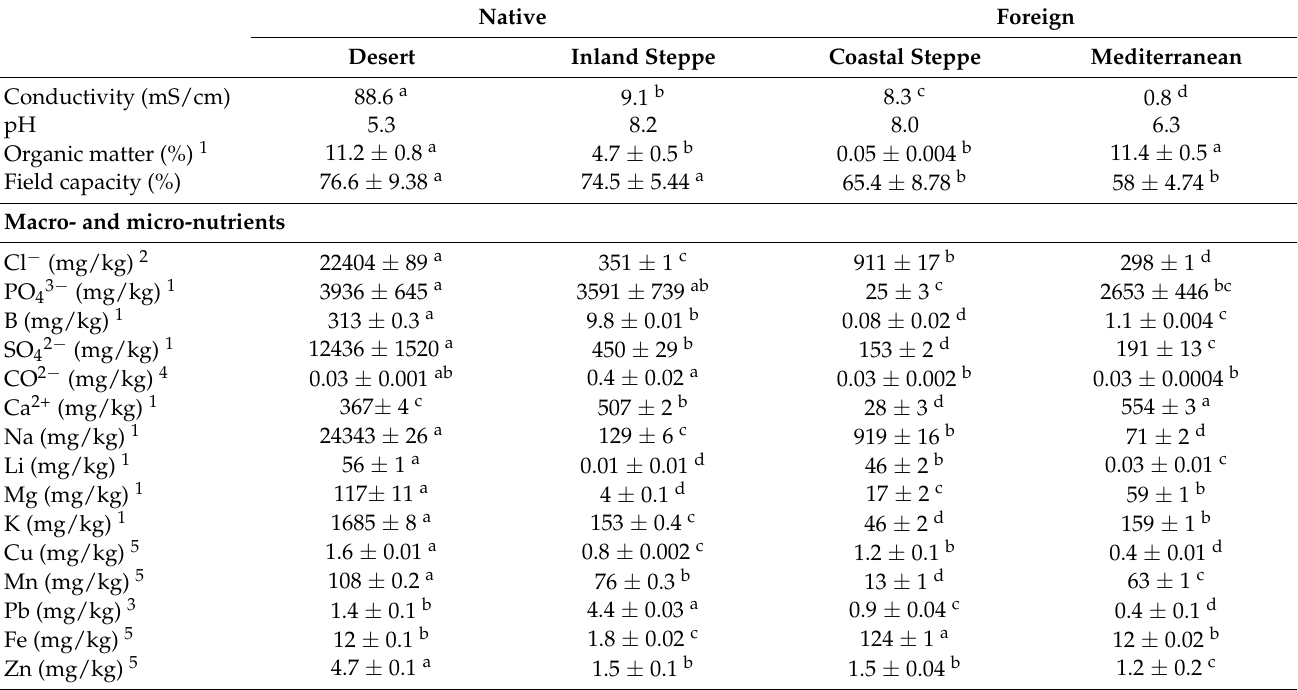
Table 1. Soils characterization. Numbers represent mean value ± Standard deviation of n = 3 soil samples. Superscript lowercase letters represent Fisher’s least significant difference (LSD) when α = 0.05 from Kruskal–Wallis testing differences between